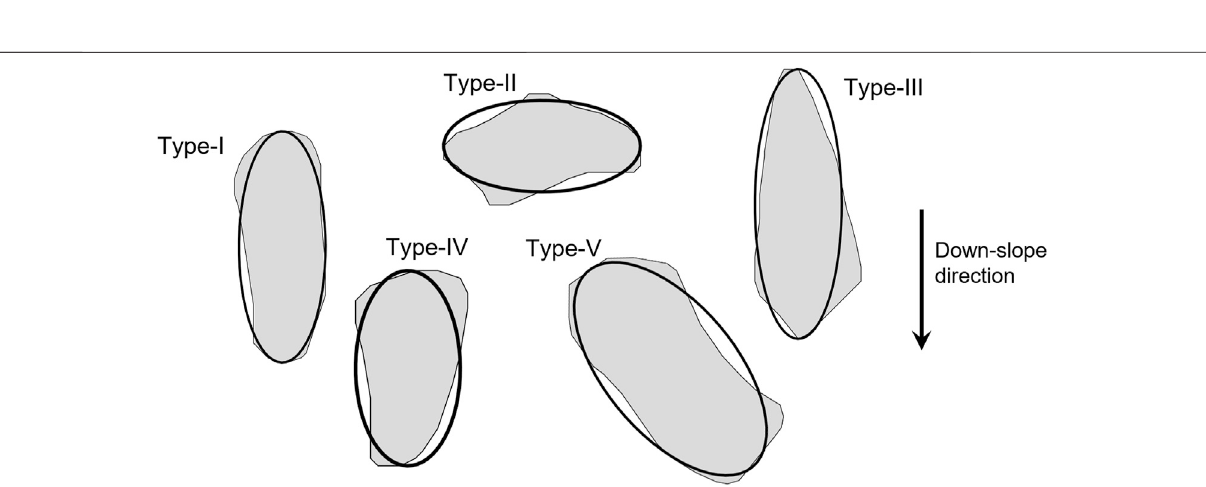
(cid:129) Type I: Elliptical shape with major axis approximately in the down-slope direction. (cid:129) Type II: Elliptical shape with minor axis approximately in the down-slope direction. (cid:129) Type III: Ovate or lanceolate shape, of which the downstream part is wider. (cid:129) Type IV: Obovate or oblanceolate shape, of which the upstream part is wider. (cid:129) Type V: Concave hull, which can be seen as a distortion of the above types (Types I to IV).